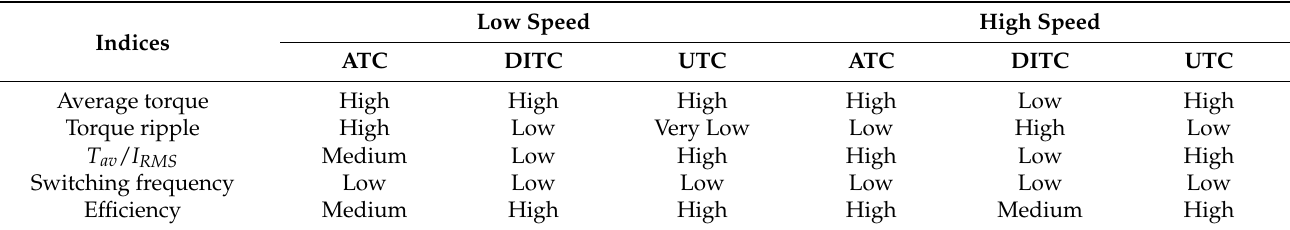
Table 1. Summary of comparison results over speed ranges.